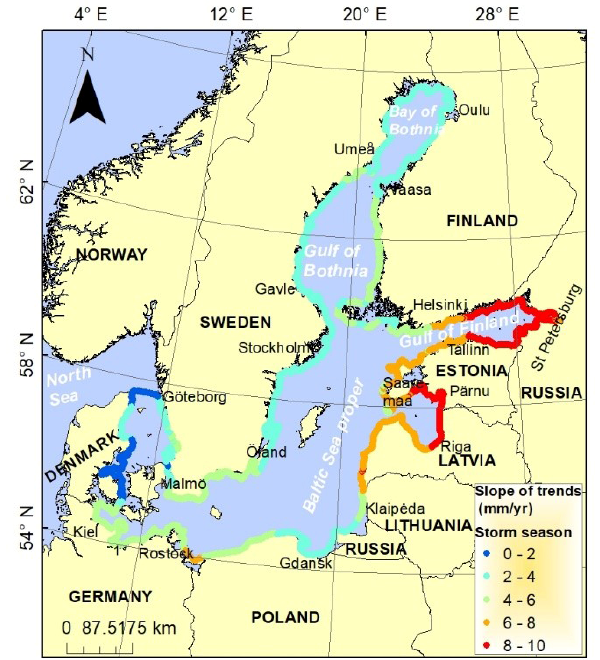
Figure 7. Trends of storm season (from July to June of the sub- sequent year) maximum water level derived from simulated to- tal water level in 1961–2004/2005. Reproduced from Pindsoo and Soomere (2020) with permission from Elsevier and the